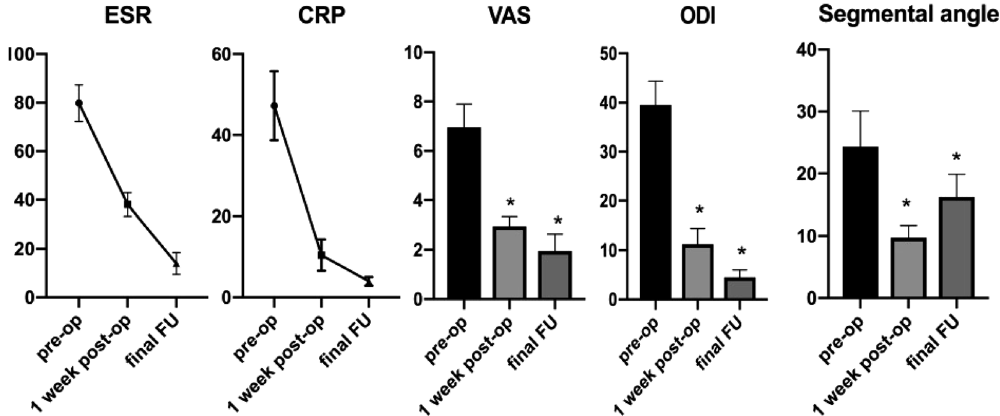
Figure 2. Presentation of ESR, CRP VAS, ODI, Segmental angle of preoperation, 1 week postoperation, final follow-up.